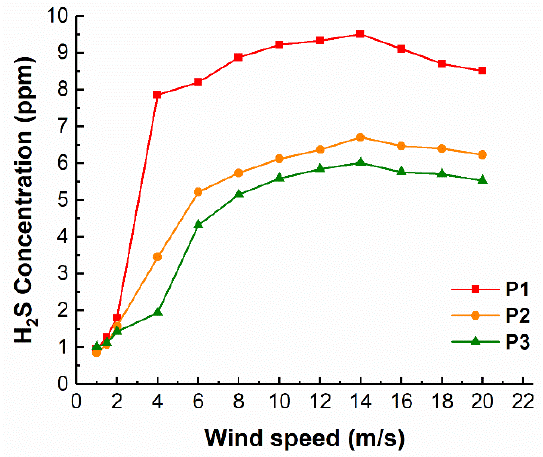
Figure 7. H 2 S concentration at P1, P2, and P3 with wind speed change only (from 2 m/s to 20 m/s). The temperature was a constant at 298 K.